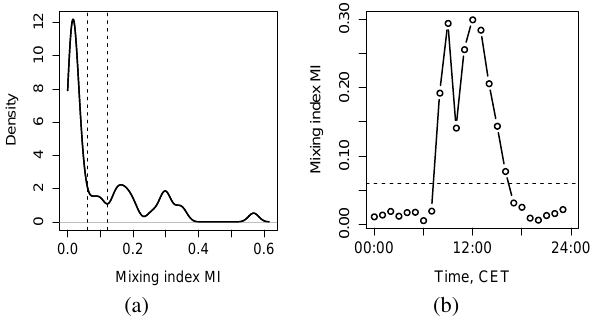
Fig. 4. Density distribution of mixing index MI (solid line). Dashed lines at MI=0.06 and MI=0.12 enclose range for sensible choices of a critical mixing index MI c , (a) . Diurnal course of mixing index on 29 June 2008 (solid line) and MI c (dashed line), (b) . MI is representative for the whole sample point field (see Sect. 2.6 for details of the calculation).